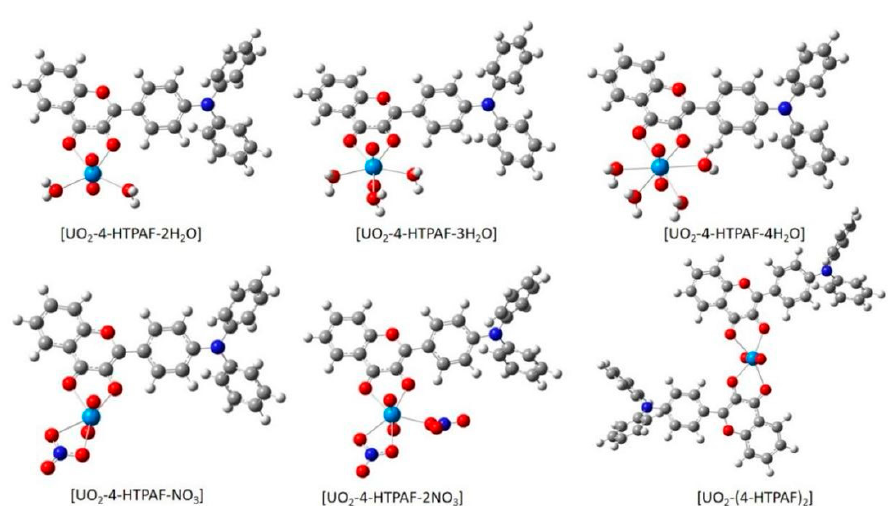
Figure 9. Possible coordination structures of uranyl with probe (HTPAF) and auxiliary ligands (H 2 O, NO 3 − ) obtained by DFT calculation. Table 1. the binding energy of coordination compounds formed by HTPAF and UO 22+ .